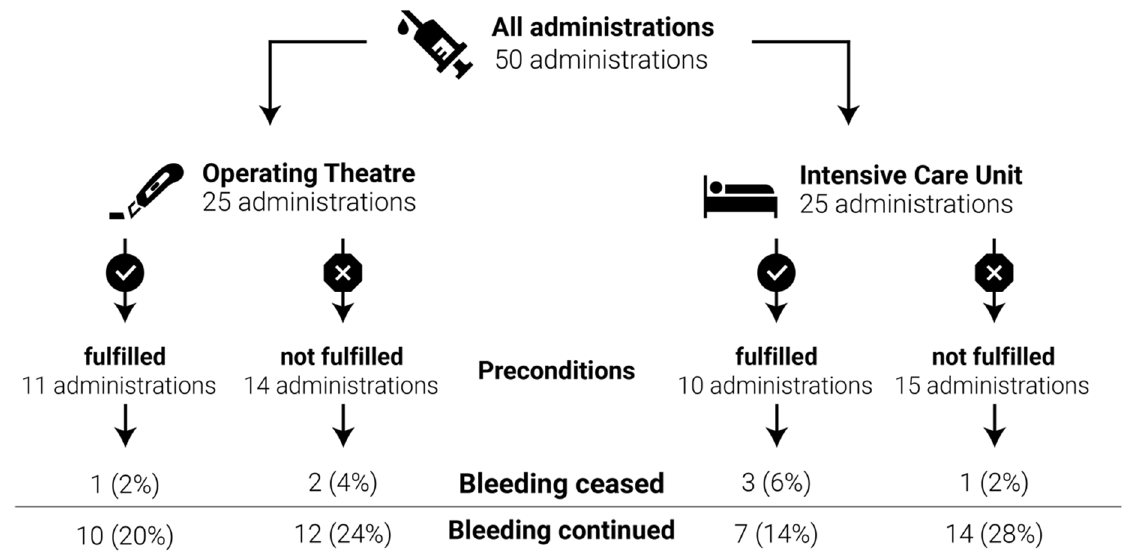
Figure 3. Administration of rFVIIa grouped by patients who (a) ful fi lled the recommended precon- ditions and (b) did not fulfill the recommended preconditions in (i) the operating room and (ii) the ditions and (b) did not ful fi ll the recommended preconditions in (i) the operating room and (ii) the intensive care intensive care unit.